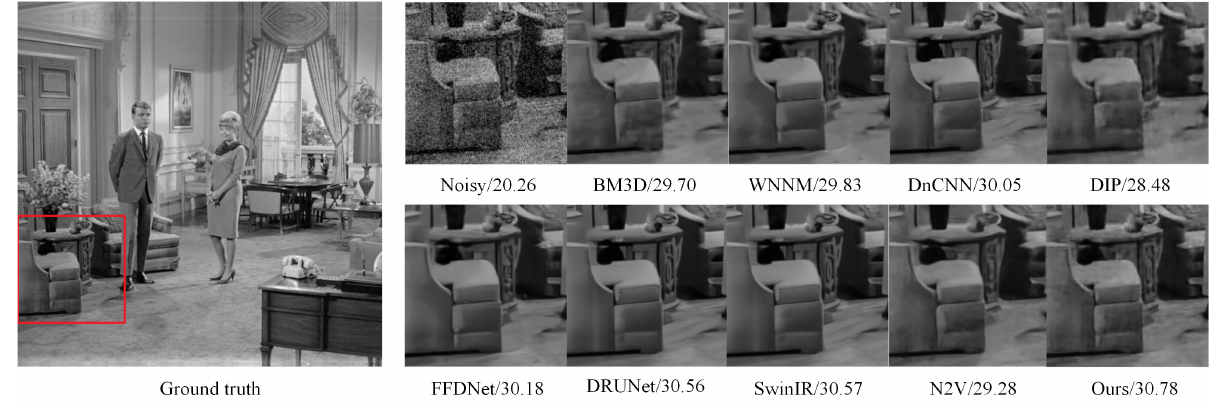
Figure 8. Visual comparison of our proposed method against the competing methods with the quantitative PSNR results listed behind the noisy and denoised images.